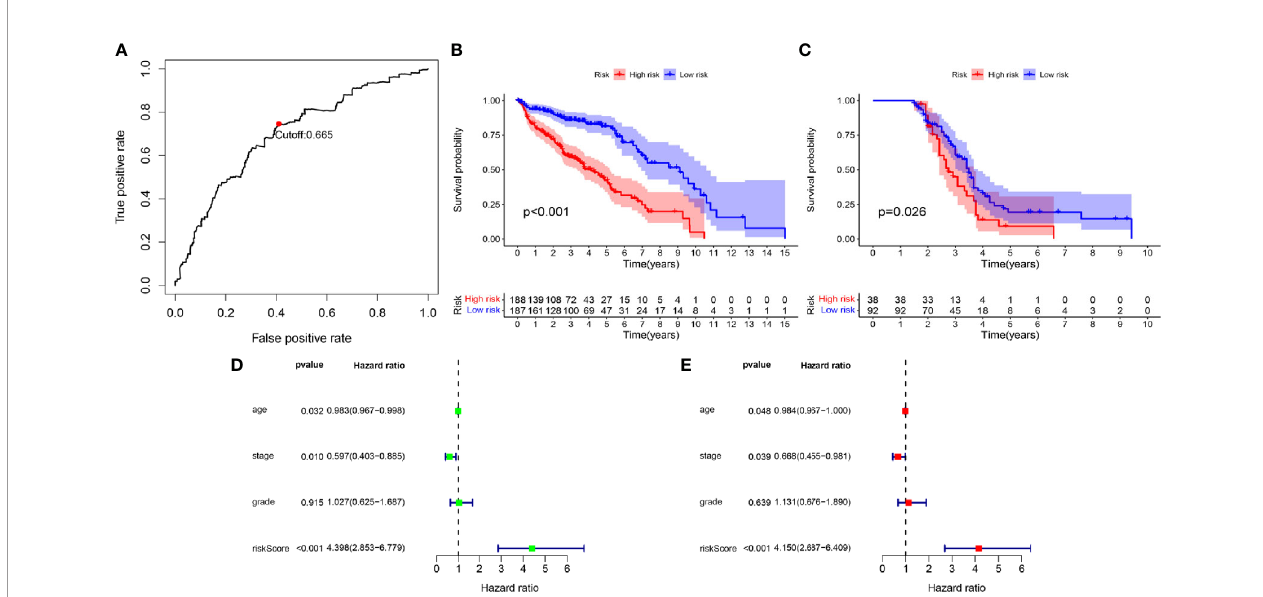
FIGURE 3 | (A) Time-dependent receiver operating characteristic (tROC) analysis of the prognostic risk score model. (B) Kaplan-Meier curve of overall survival in model group. (C) Kaplan-Meier curve of overall survival in validation group. (D) Univariate-Cox regression analyze of prognostic factors in model group. (E) Multivariate-Cox regression analyze of prognostic factors in model group.